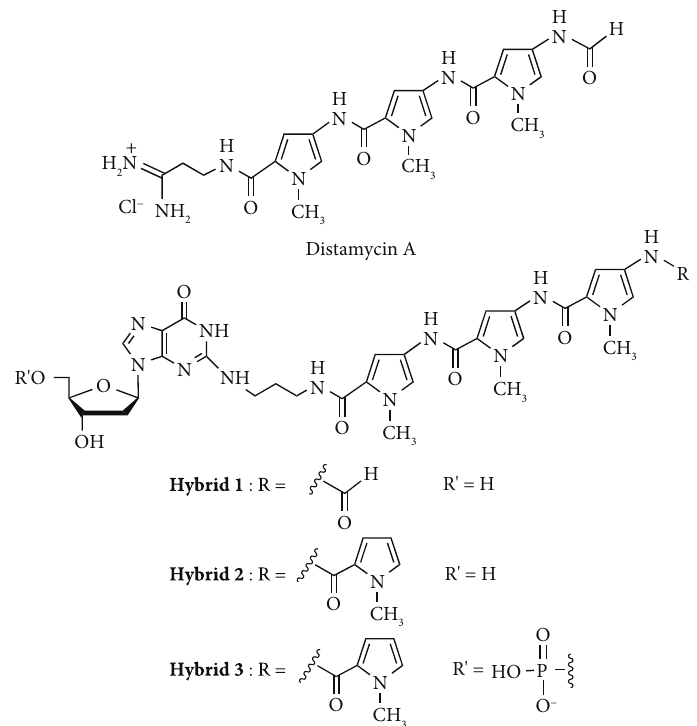
Figure 1: Structures of distamycin A, hybrids 1 , 2 , and 3